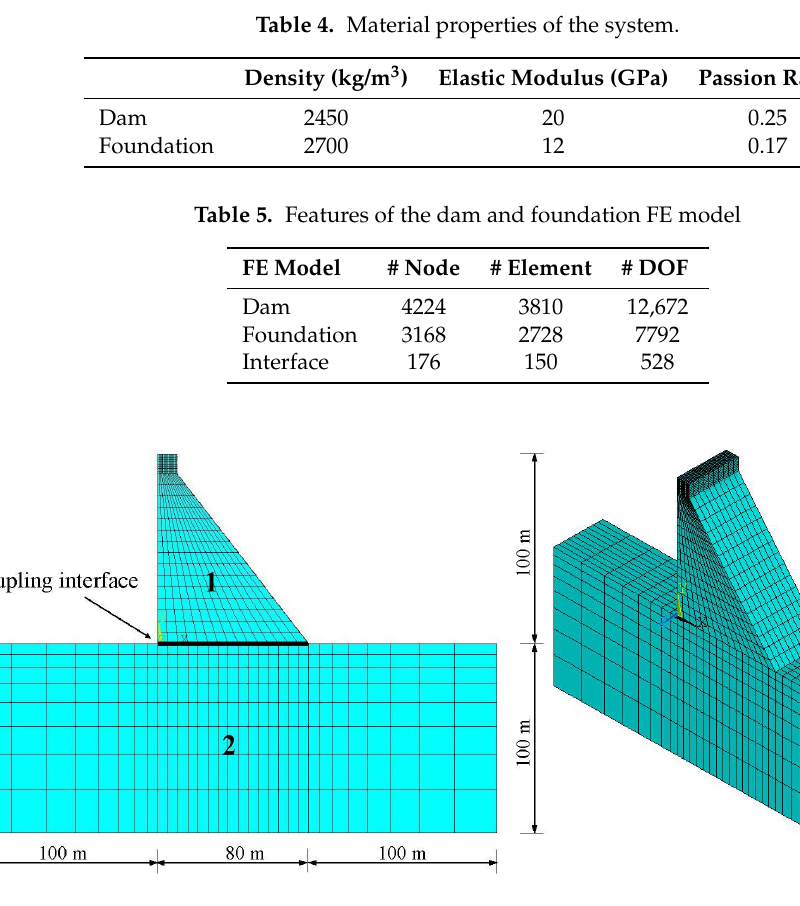
Figure 12. Finite element model and dimensions of the simplified dam-foundation system.